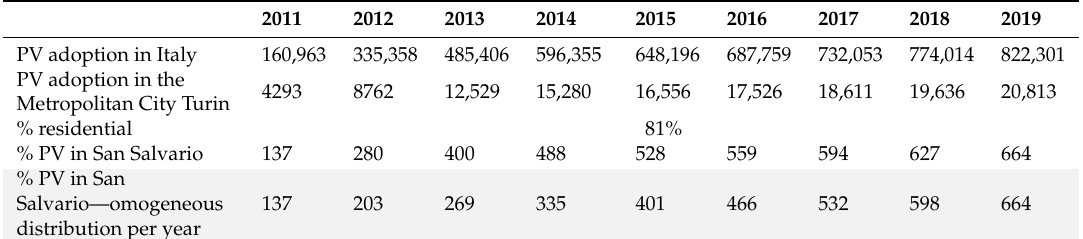
Table 5. PV di ff usion in Italy and the metropolitan city of Turin provided by GSE [47], used to identify the number of adoptions in the San Salvario neighborhood.